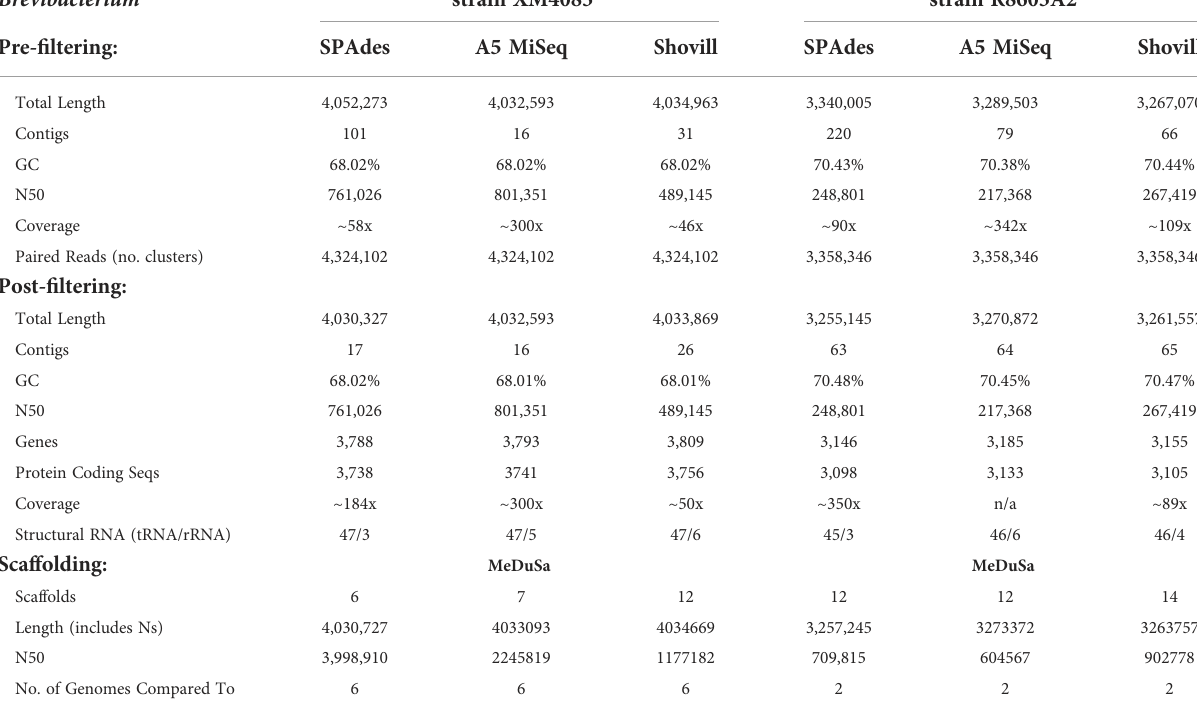
TABLE 4 Comparative assembly statistics for Brevibacterium